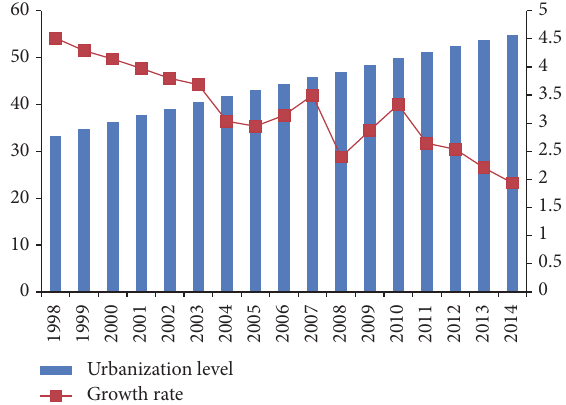
Figure 4: Urbanization level in China from 1998 to 2014 (%) and the growth rate